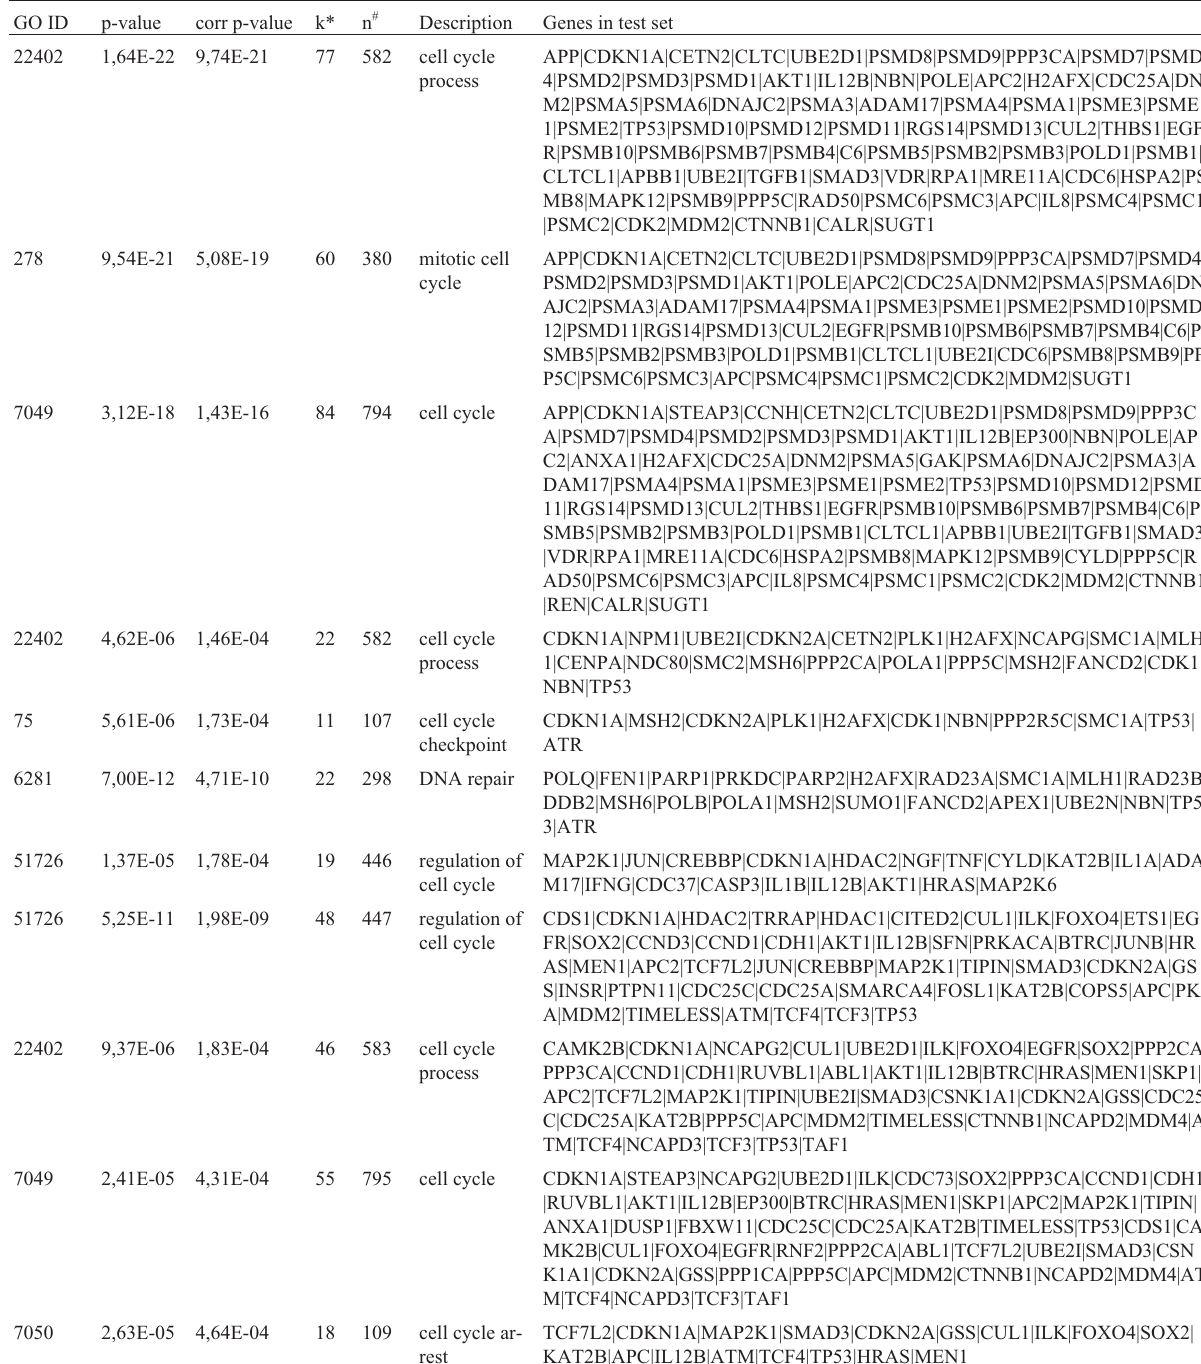
Table 2 - Major cell cycle bioprocesses in clusters 6, 11, 13 and 14 associated with MIOs, IEs and